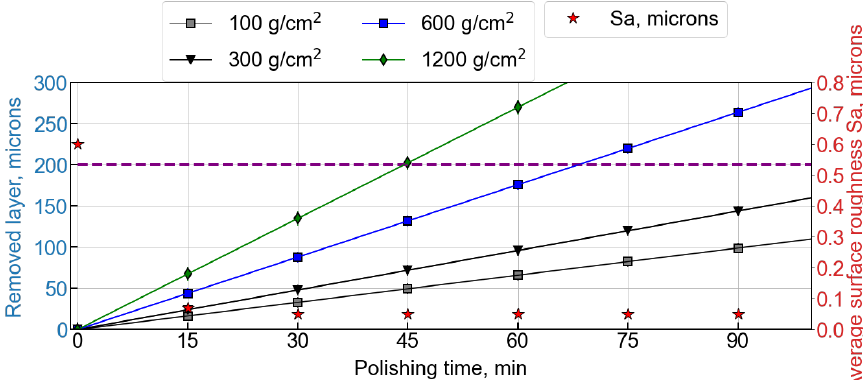
Figure 6. Evolution of removed layer and roughness versus time during the lapping step. Note: the left vertical axis applies to solid-line curves, and the right vertical axis (red color) applies to point type (red stars).